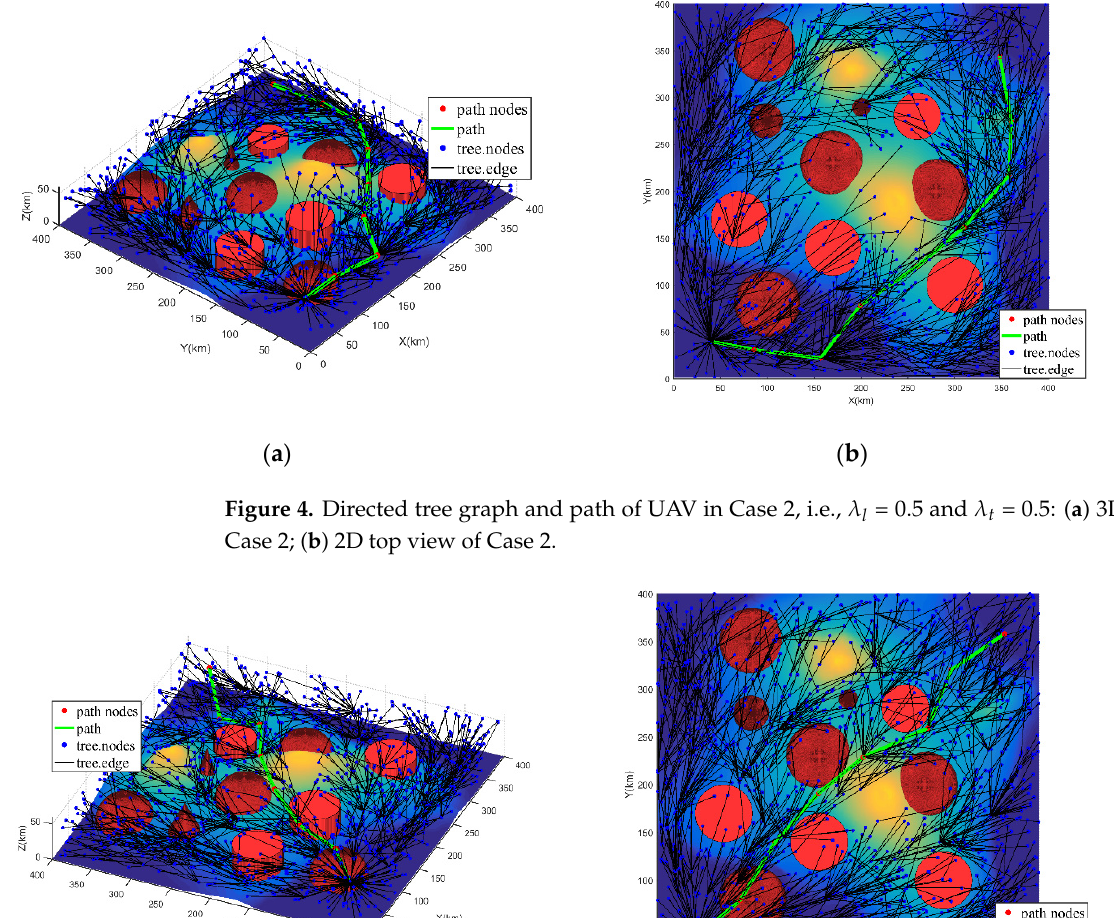
Figure 3. Directed tree graph and path of UAV in Case 1, i.e., l Case 1; ( b ) 2D top view of Case 1.